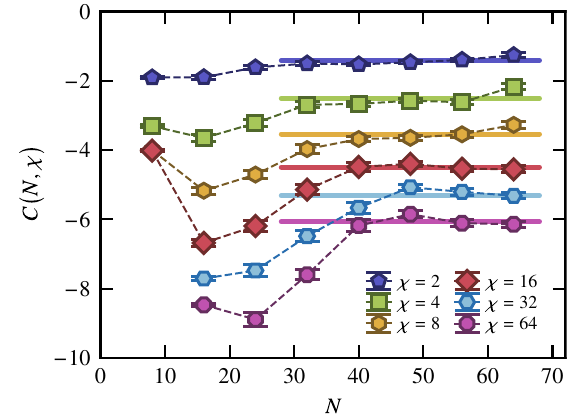
FIG. 9. The cost versus the size N of 3-regular graphs with a unit weight (QAOA depth p = 1) for various values of the bond dimension χ . Each data point corresponds to the statistical aver- age of 100 independent instances. The straight solid lines are a guide to the eye, highlighting that at fixed χ (cid:13) χ exact , the cost is roughly constant versus the size N . Note that unlike other plots in the paper, we do not use a matrix-product-operator representa- tion of the quantum circuit but we apply one-qubit and two-qubit gates individually on the matrix product state representing the quantum